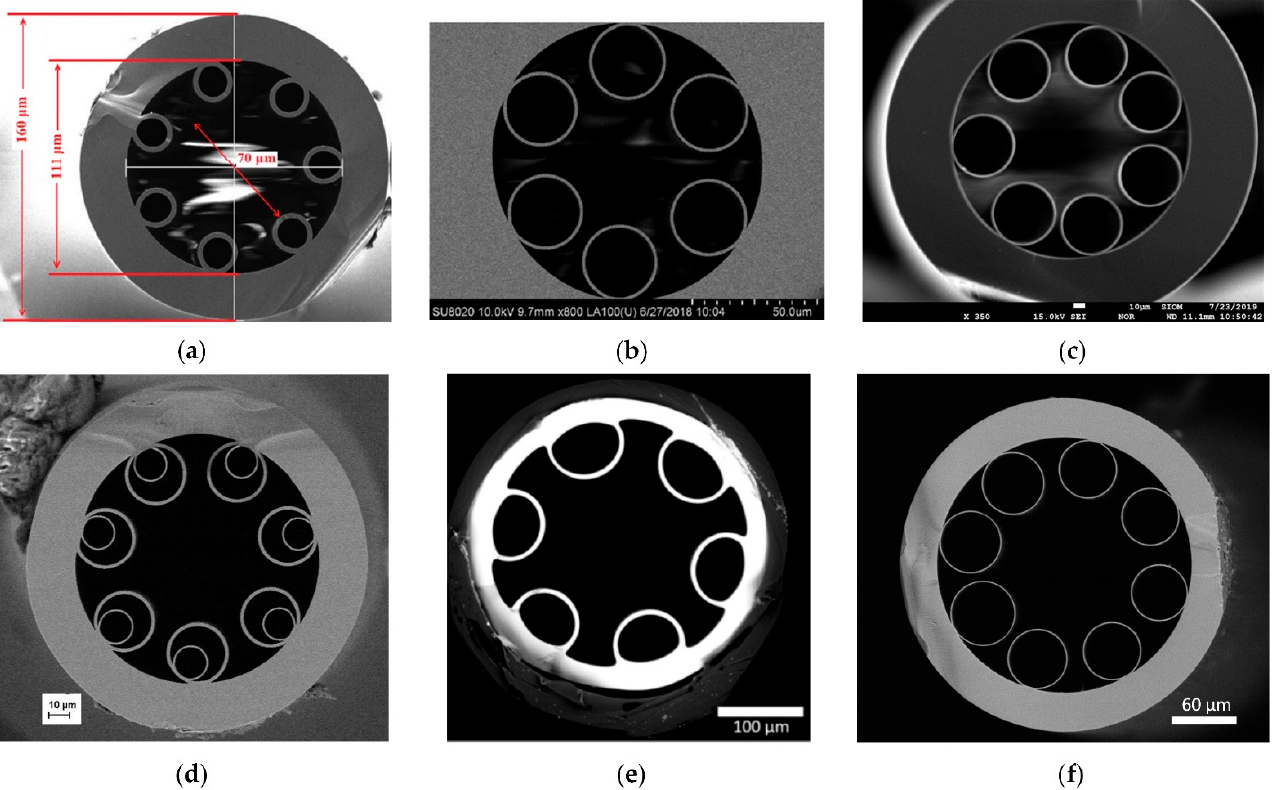
Figure 1. Examples of ARHCFs used in gas sensing systems. ( a ) Silica-based ARHCF is designed to operate in the 2 µm wavelength range with a core size of 70 µm. Reprinted with permission from [21] © The Optical Society. ( b ) Six-capillary cladding silica-based ARHCF with a core diameter of 65 µm for guidance at ~1.55 µm and 3.34 µm. Reprinted with permission from [26] © The Optical Society. ( c ) Seven-capillary cladding silica-based ARHCF with a core size of 84 µm providing low-loss transmission in the near- and mid-IR. Reprinted with permission by MDPI from [8]. ( d ) Silica-based ARHCF with nested capillary cladding and a core diameter of 65 µm for guidance at ~4.54 µm. Reprinted with permission from [27] © The Optical Society. ( e ) Tellurite ARHCF enabling light guidance ~5 µm inside a hollow core with a 139 µm diameter. Reprinted with permission from [28] © The Optical Society. ( f ) 5.26 µm-guiding borosilicate glass-based ARHCF with a core size of 122 µm.